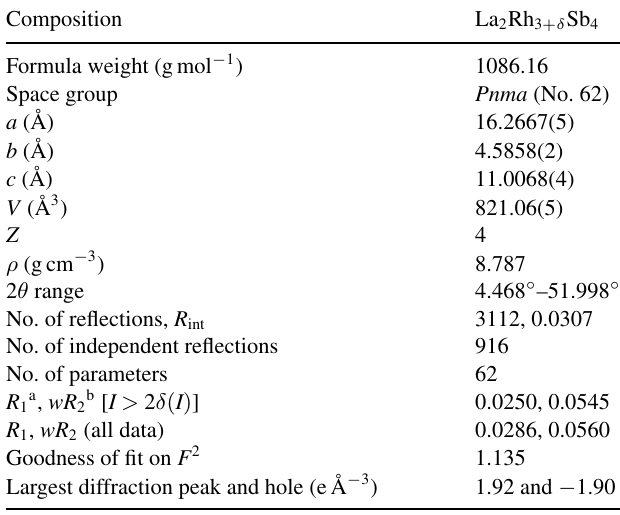
Table 1. Single-crystal XRD refinement data for La 2 Rh 3 + δ Sb 4 at